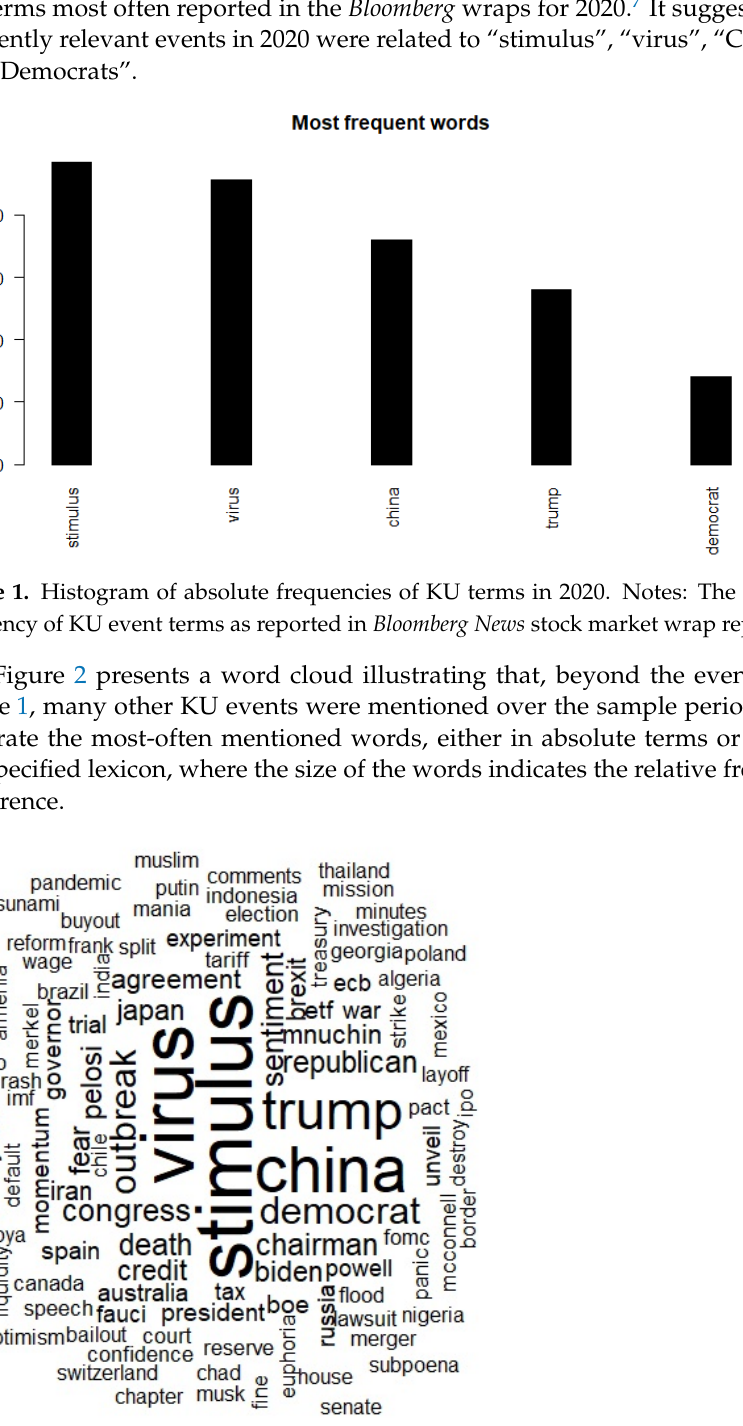
Figure 2. Bloomberg News WordCloud of KU Factors in 2020. Notes: The WordCloud is based on the co-author’s dictionary lexicon of KU events reported in Bloomberg News stock market wrap reports for 2020.